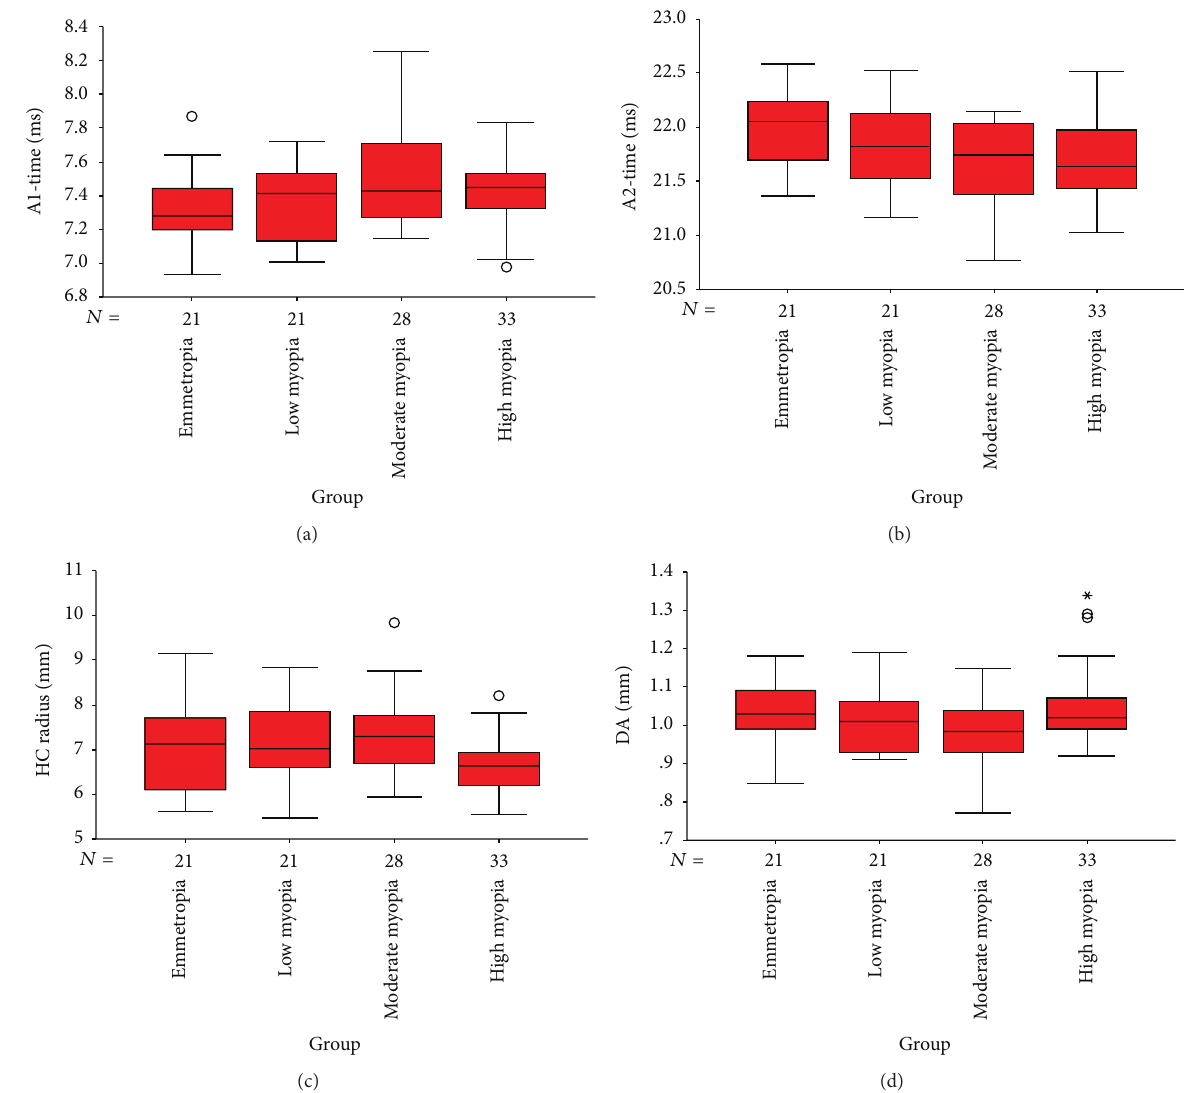
Figure 2: Box plots showing the distribution percentage difference between 4 groups for the A1-time, A2-time, HC radius, and deformation amplitude (DA) levels. The median for each data set is indicated by the center line, and the first and third quartiles are represented by the edges of the area, which is known as the interquartile range (IQR). The 95%/5% confidence intervals are represented by the ends of the lines extending from the IQR. Circles denote outliers with values more than 1.5 IQR from the upper or lower edge of the